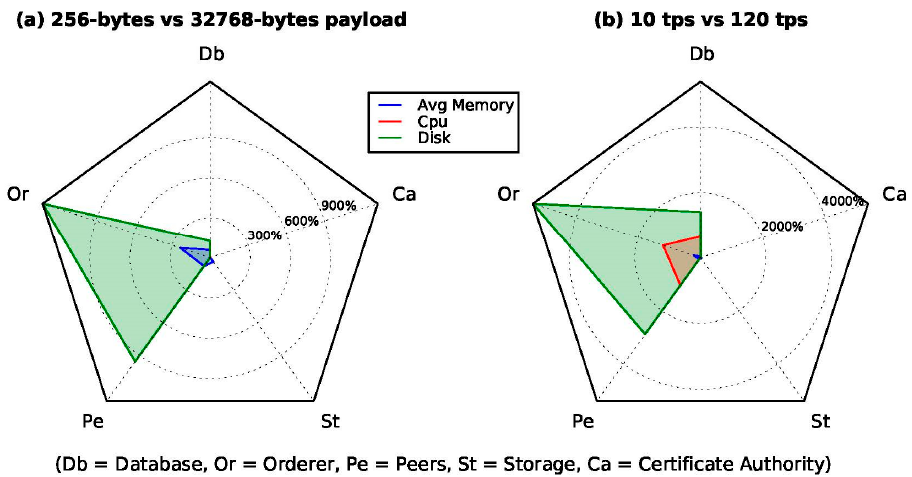
Figure 8 . Impact of the smart contract writeOnchainData with bigger payload ( a ) and higher Tps ( b ).